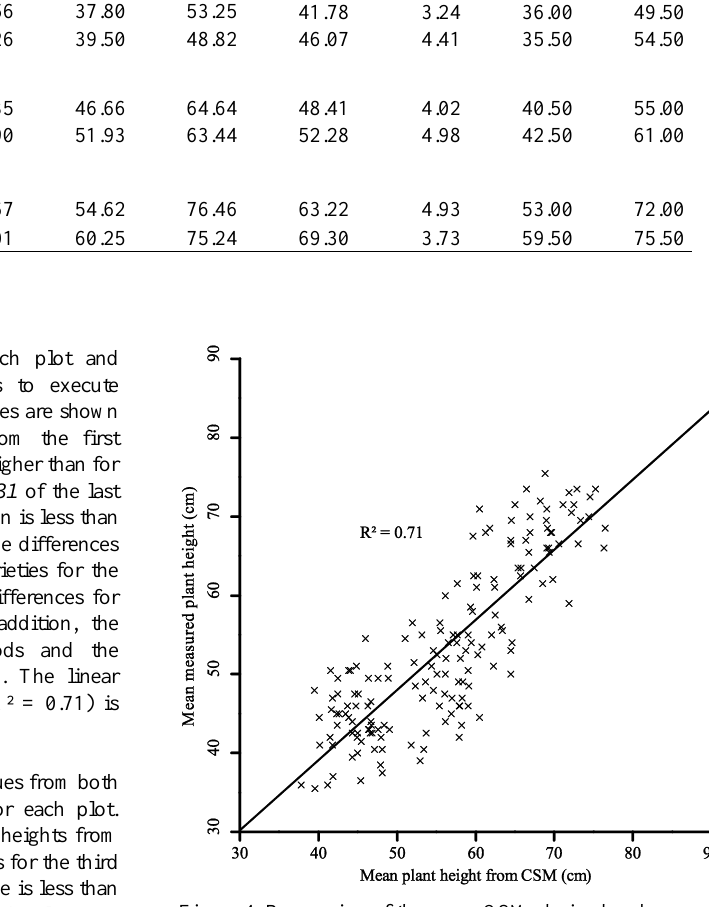
Figure 4. Regression of the mean CSM-derived and manually measured plant heights (n = 162).